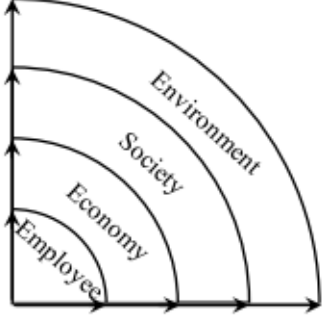
Figure 3. Approach of OSH and environment [28].